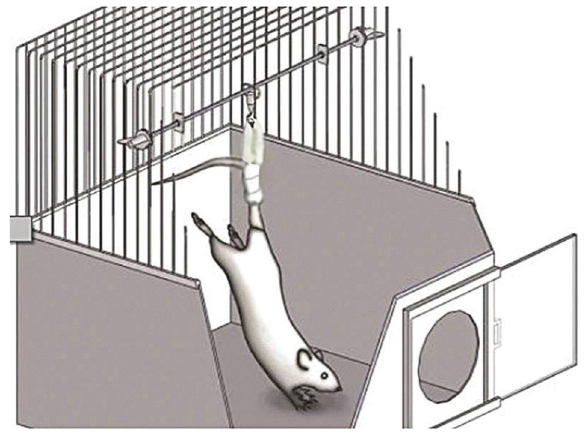
Figure 2. Schematic drawing of the rat tail suspension model.